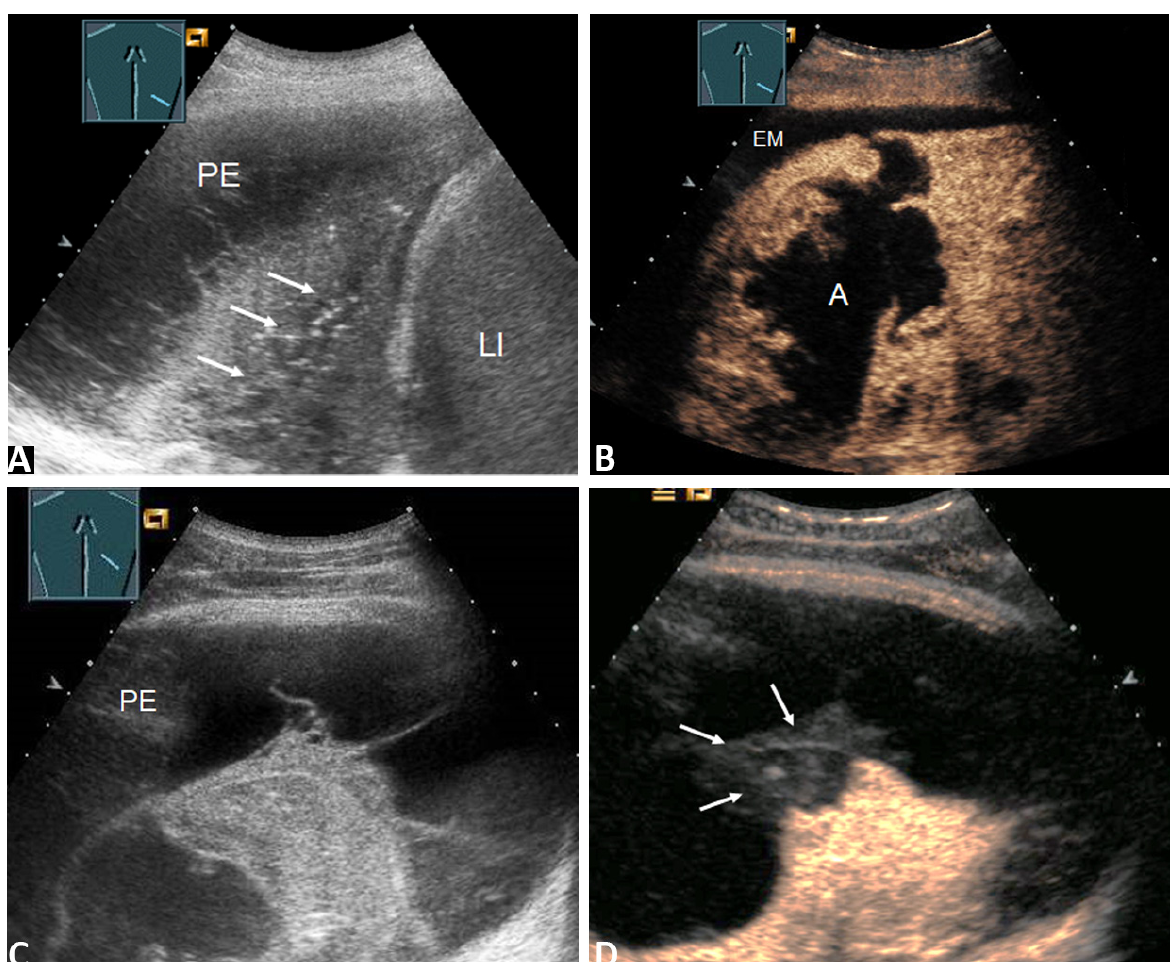
Figure 5. ( A ) 68-year-old patient with a right lateral PE. Effusion cytology was negative. B-TUS shows a PE with septa and inhomogeneous lung consolidation (arrows); ( B ) In the CEUS images, the lung consolidation shows a large anechoic liquidation, such as in cases of abscess or necrosis. The final diagnosis was a malignant PE due to central non-small cell lung carcinoma (NSCLC) with consecutive lung abscess (A) and pleural empyema (EM). LI = Liver. ( C ) 27-year-old patient with fever and a right-sided PE. Effusion cytology was negative B-TUS shows a PE with septation and lung consolidation; ( D ) CEUS shows consolidation with inhomogeneous enhancement and a peripheral non-enhanced wedge-shaped area similar to a pulmonary infarction (arrows). The final diagnosis was a benign PE with a pulmonary artery embolism morphologically confirmed through CT pulmonary angiography and histologically confirmed infarct pneumonia.